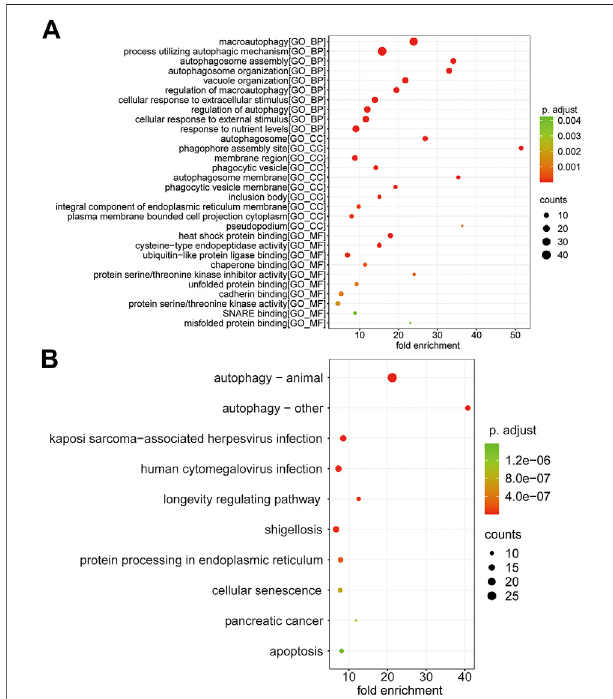
FIGURE6| Functionalanalysisof110ARMGsintheTcellCD8Hcluster. (A) GO enrichment result of ARMGs. The x-axis label represents fold enrichment and y-axis label represents GO terms. (B) Top 10 signi fi cantly enriched KEGG pathway in ARMGs. Y-axis label represents pathway, and X-axis label represents fold enrichment. Size and color of the bubble represent amount of ARMGs enriched in term and enrichment signi fi cance, respectively.Thelargerthecircle,themoregenesitcontained;conversely,the smaller the circle, the fewer genes it contained. The color of the circle is correlated with the p Value. The lower the p Value is, the closer it is to the red value. The higher the p Value is, the closer it is to the green value. GO, Gene Ontology; KEGG, Kyoto Encyclopedia of Genes and Genomes; ARMGs, autophagy-related marker genes. “ BP ” stands for “ biological process ” , “ CC ” stands for “ cellular component ” and “ MF ” stands for “ molecular function ”